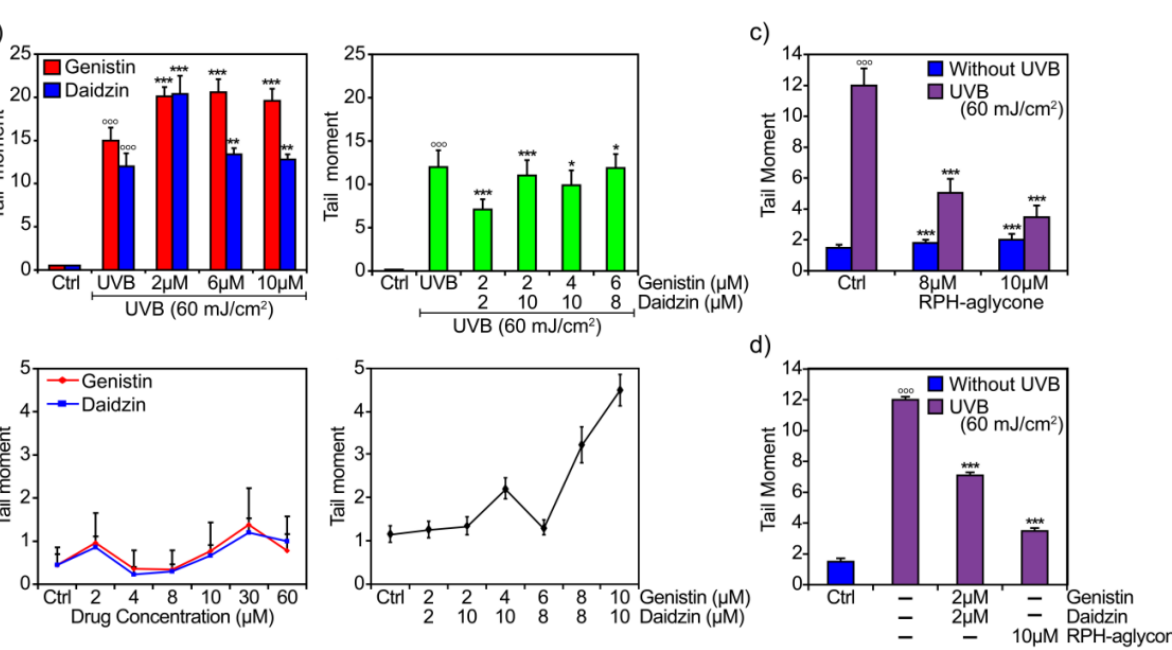
Figure 5. Analysis of UVB-induced DNA damage by the comet assay. ( a ) (left panel) BJ-5ta cells were treated for 2 h with different concentrations of genistin or daidzin (from 2 µM to 10 µM) before UVB irradiation and were harvested 24 h after UVB irradiation (60 mJ/cm 2 ); ( a ) (right panel) BJ-5ta cells were treated for 2 h with different combinations of genistin and daidzin before UVB irradiation (60 mJ/cm 2 ) and were harvested 24 h after UVB irradiation (60 mJ/cm 2 ); ( b ) (left panel) BJ-5ta cells were treated for 2 h with various concentrations of genistin or daidzin (from 2 µM to 60 µM) and were harvested 24 h after treatment; ( b ) (right panel) BJ-5ta cells were treated for 2 h with different combinations of genistin and daidzin and were harvested 24 h after treatment; ( c ) BJ-5ta cells were treated with RPH-aglycone (8 µM and 10 µM) without UVB irradiation or before UVB irradiation (60 mJ/cm 2 ) and were harvested 24 h after treatment; ( d ) A comparative analysis of the photo-protective effect by the comet assay of isoflavones in the aglycone (10 µM RPH-aglycone) or glucoside forms (2 µM genistin plus 2 µM daidzin) is shown.